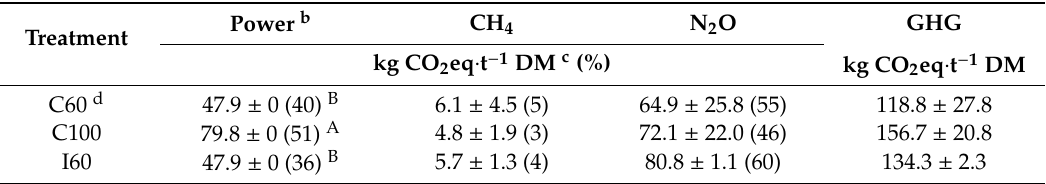
Table 3. GHG emissions and relative contributions of each sector from manure composting (values are means ± SD, n = 3) a